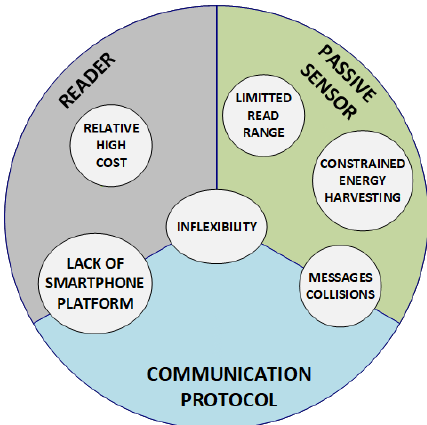
Figure 1. Overview of the main challenges that prevent radio frequency identification (RFID) from becoming pervasive. The challenges are classified according to the RFID component or components (reader, passive sensor, communication protocol) which they